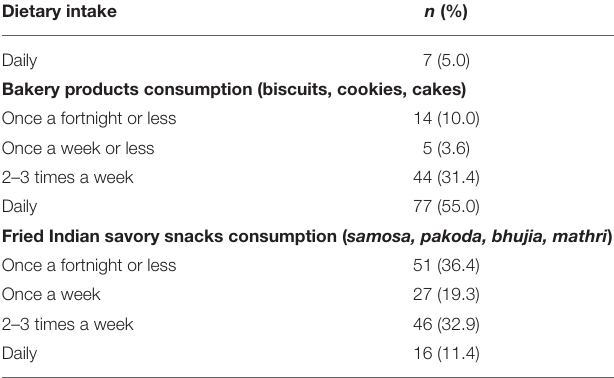
TABLE 3 | Dietary diversity and intake of HFSS and SSB among study